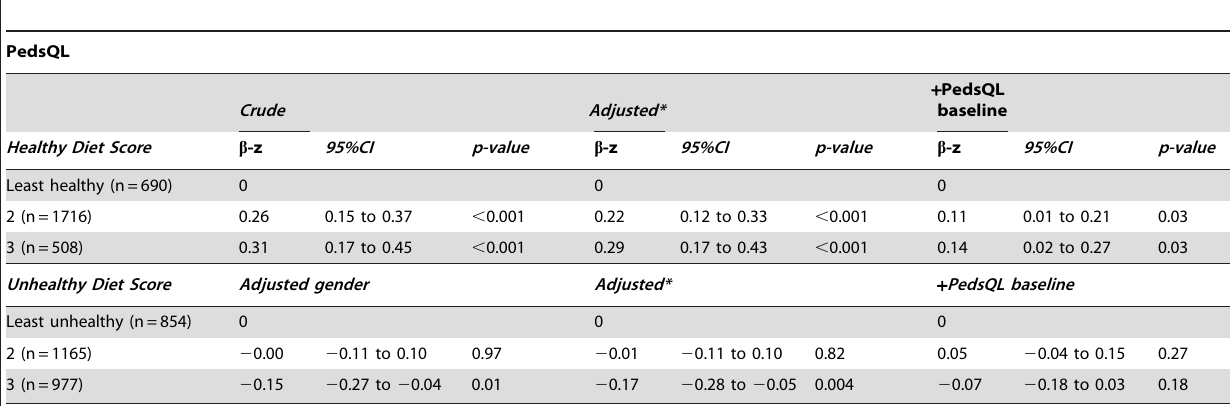
Table 3. Longitudinal associations between diet quality at baseline and PedsQL scores at follow-up: Results of multivariable linear regression